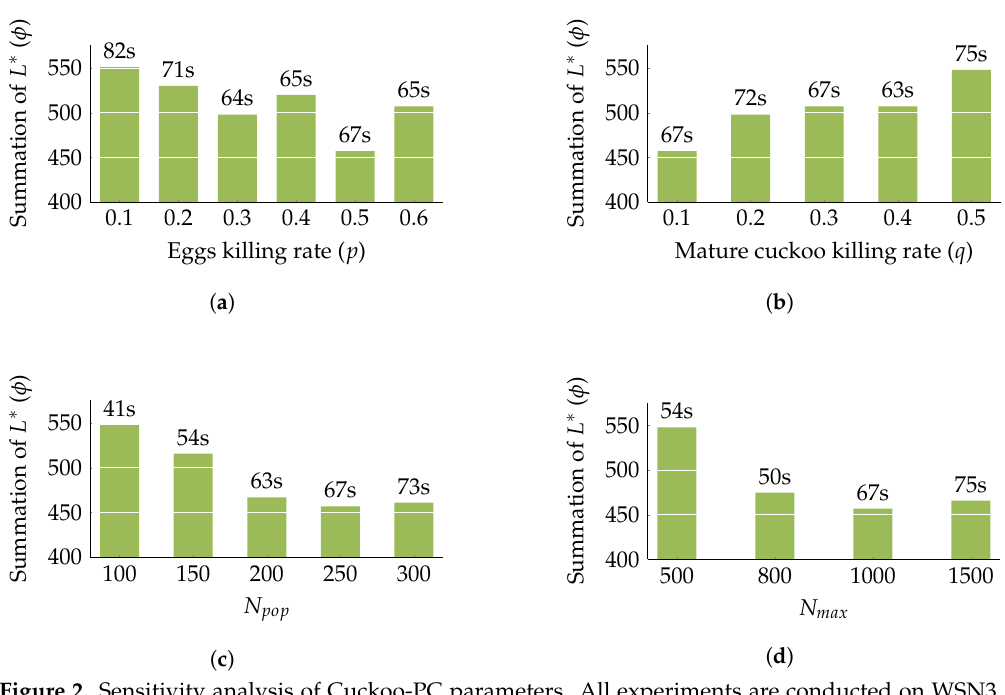
Figure 2. Sensitivity analysis of Cuckoo-PC parameters. All experiments are conducted on WSN3. ( a ) Sensitivity analysis of p , ( b ) Sensitivity analysis of q , ( c ) Sensitivity analysis of N pop , ( d ) Sensitivity analysis of N max